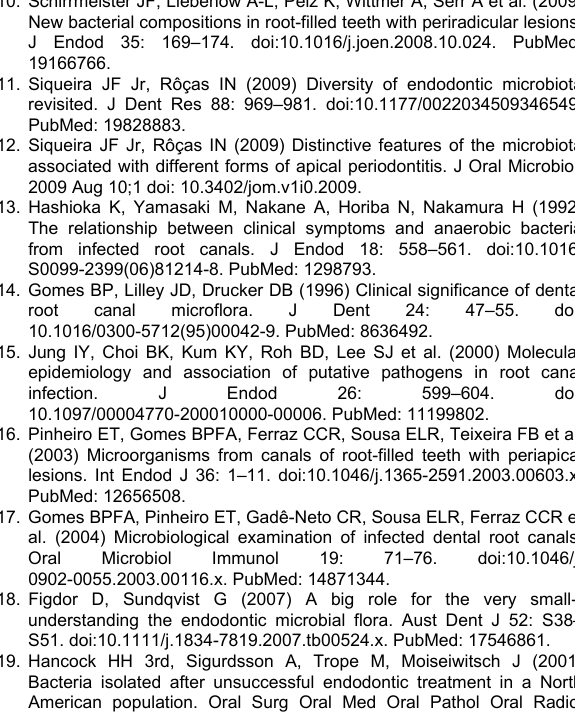
Table S1. Table showing the 25 most abundant genera found in 40 samples of root canal treated teeth with their overall abundance (standard deviation in brackets) and prevalence data.